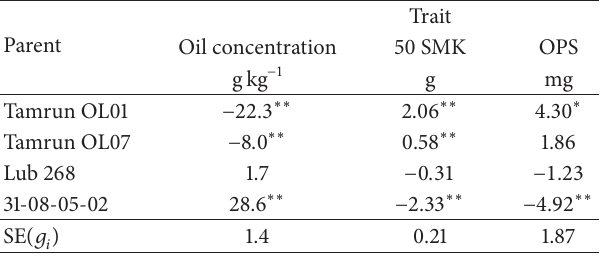
∗,∗∗ indicate terms that are significant at the 5 and 1% levels of probability,